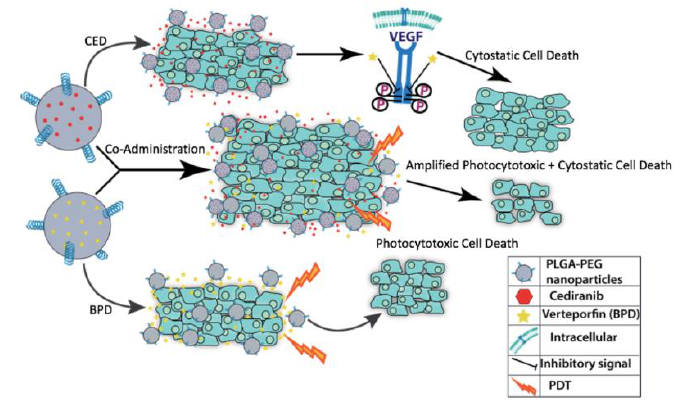
Figure 1. Cartoon schematic of the individual drug effects of Verteporfin (BPD) and Cediranib (CED) compared to the synergistic response of co-administration of both drugs to render increased cell death using these photocytotoxic and cytostatic compounds, respectively.